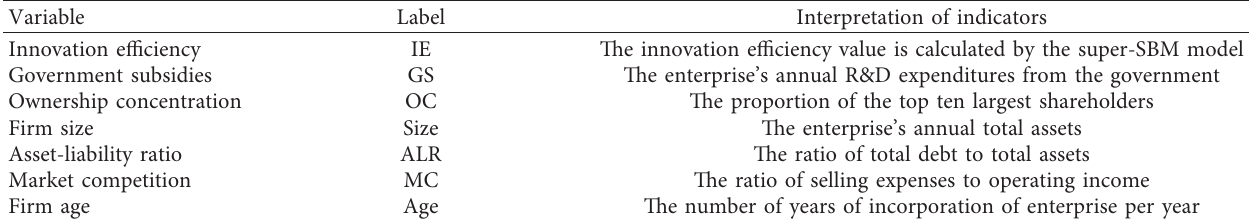
Table 2: Brief description of influential factors.